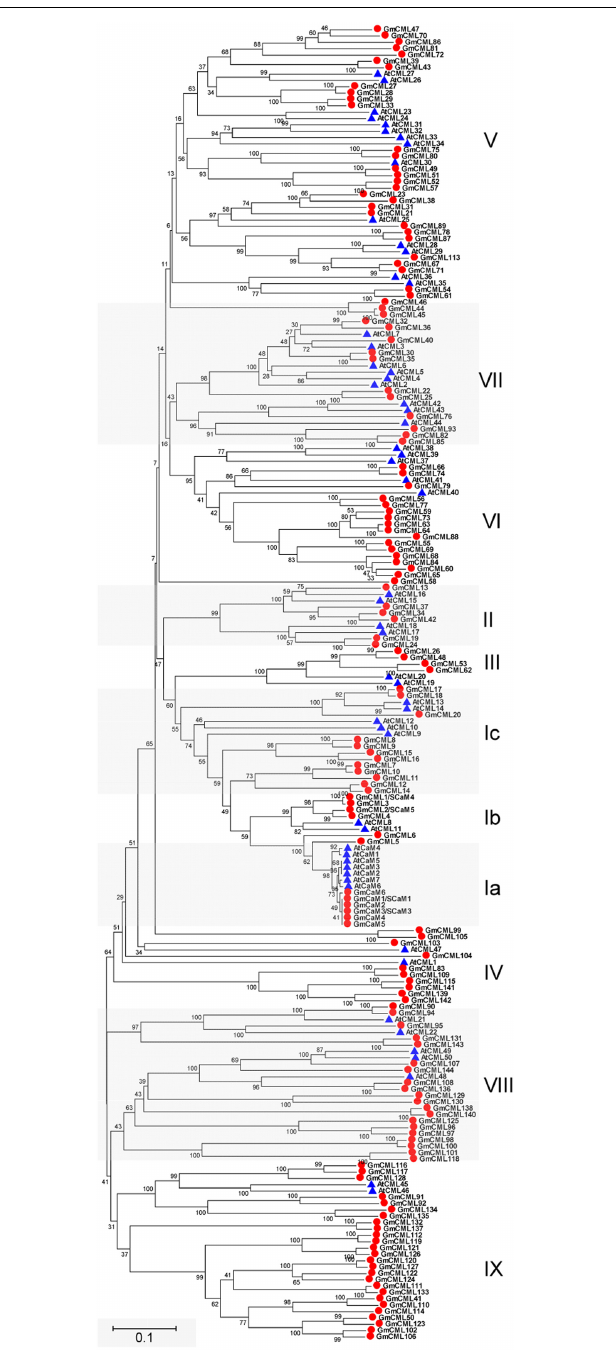
FIGURE 5 | Unrooted phylogenetic tree of the CaM and CML proteins from soybean ( G. max ) and Arabidopsis thaliana . The alignment for the phylogenetic tree was performed with ClustalW using full-length amino acid sequences. The phylogenetic tree was created with the MEGA6 software and the neighbor-joining method with 1,000 bootstrap replications. All the 150 CaM/CML proteins from soybean are marked with red circles, while 57 CaM/CML proteins from Arabidopsis are marked with blue triangles. Roman numerals designate the subfamilies. The bar indicates the relative divergence of the sequences examined and bootstrap values are displayed next to the branch.